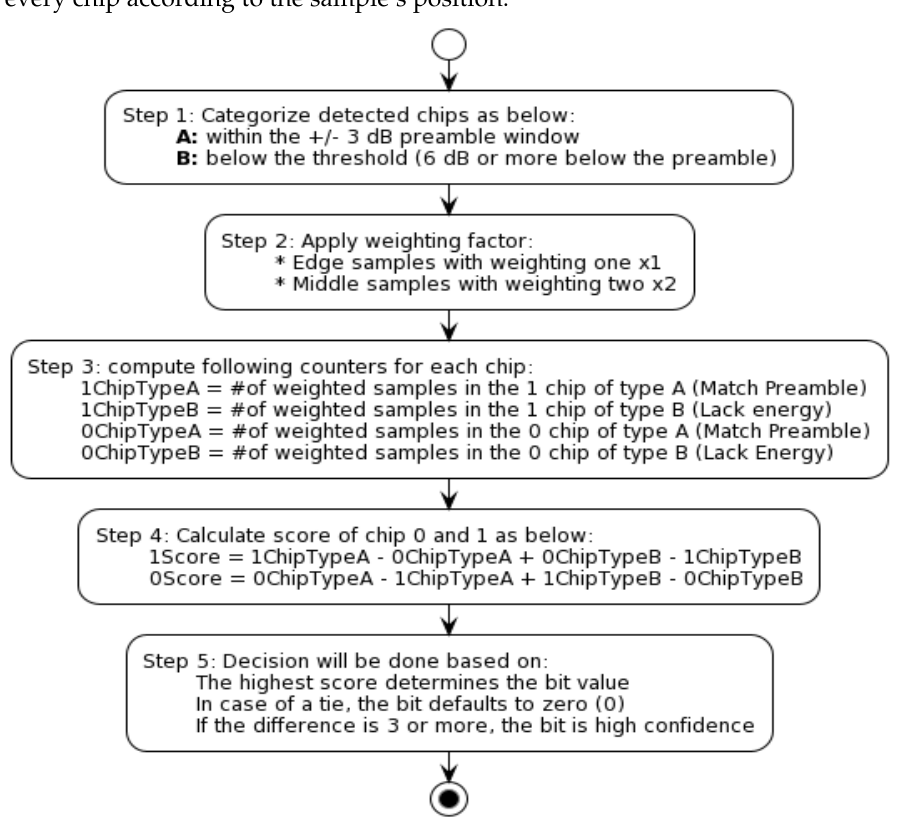
Figure 4. Enhanced Bit Detection and Confidence Declaration algorithm by using the multi-sample technique .